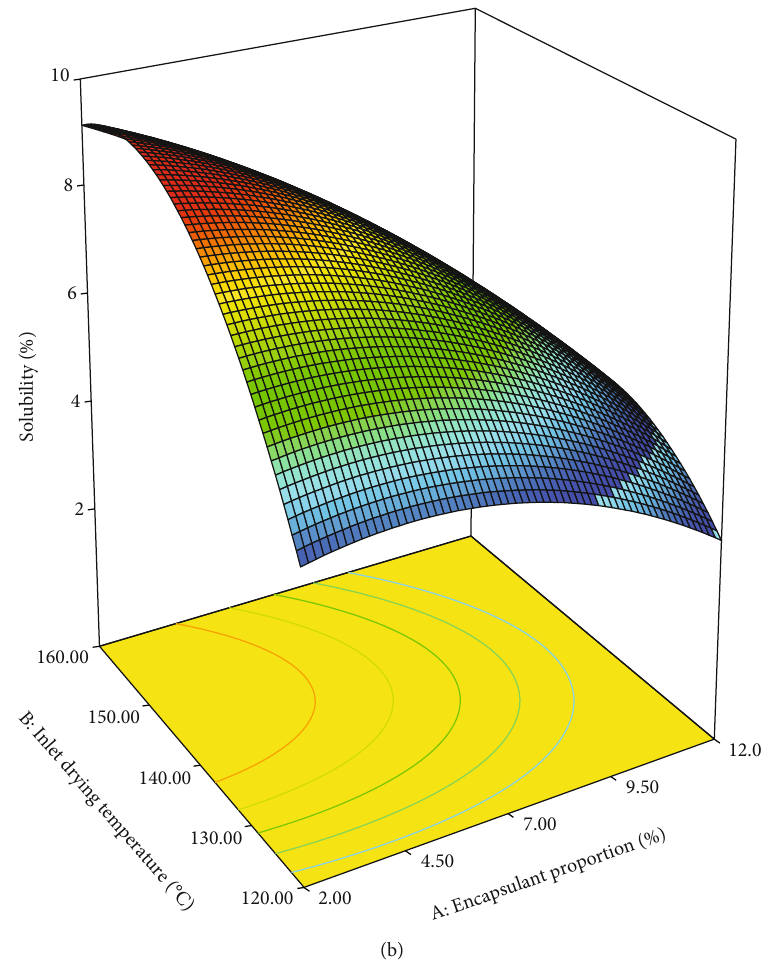
Figure 3: E ff ect of IDT and encapsulant proportion on hygroscopicity (a) and solubility (b) of PME